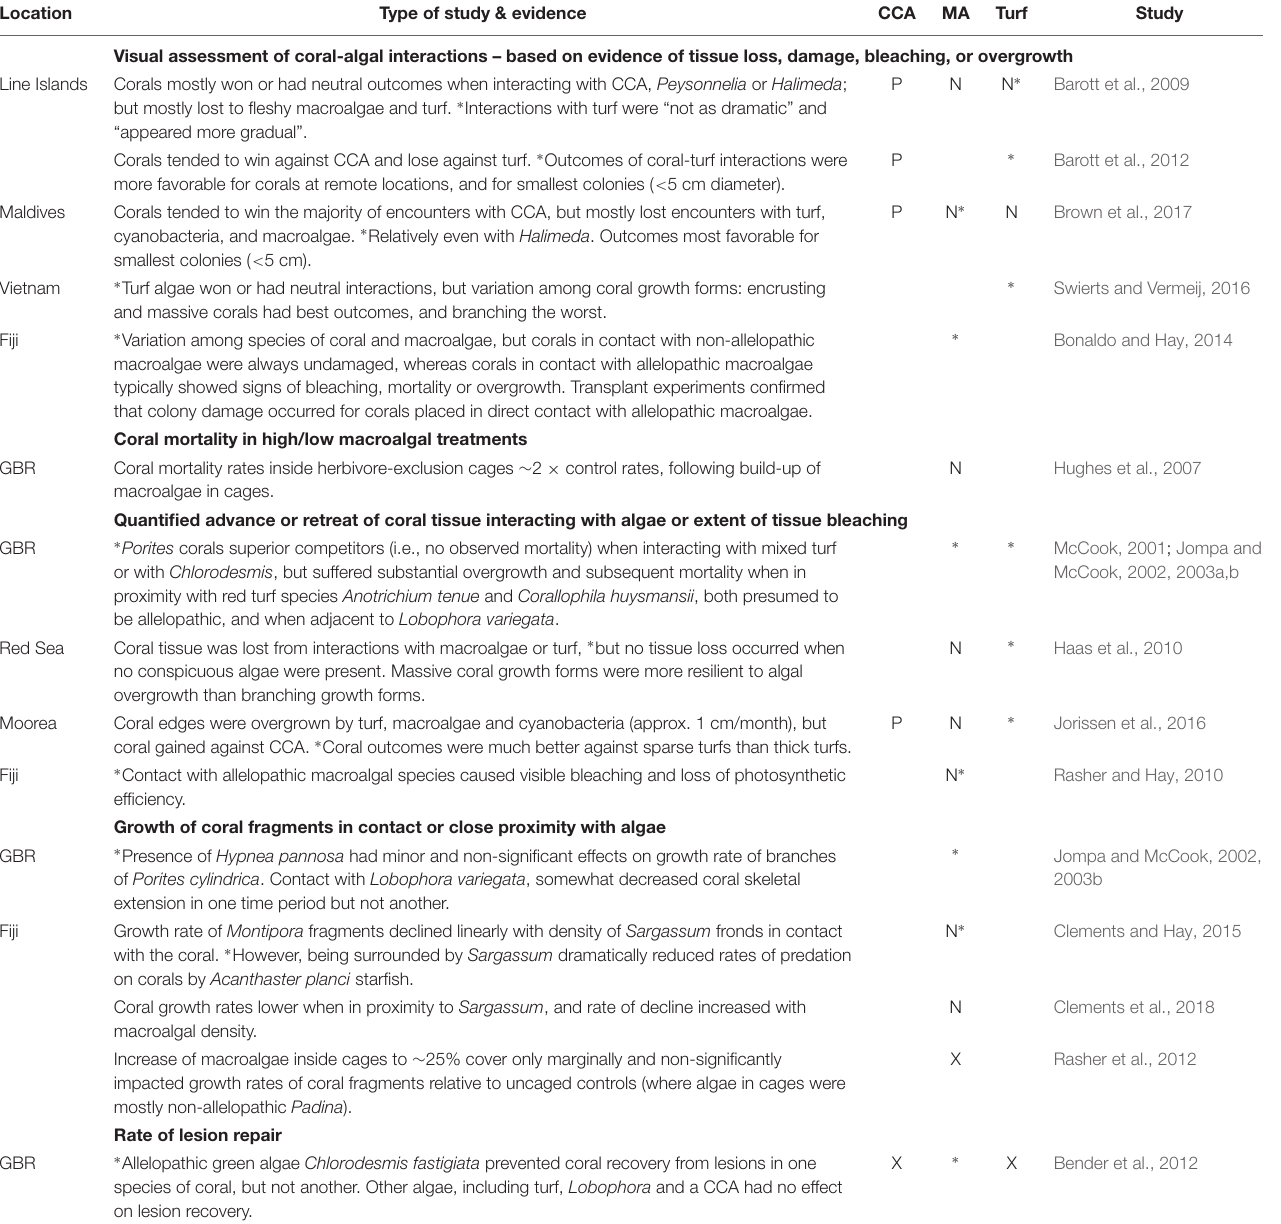
TABLE 1 | Effects of benthic algae on coral condition, mortality, and growth.